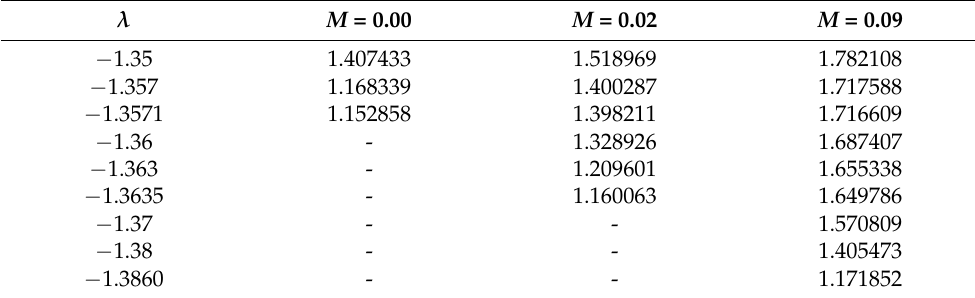
Table 4. Values of f (cid:48)(cid:48) ( 0 ) as φ 1 = φ 2 = 0.01, α = 3.0, β = 0.5, Ec = 0.1, and Pr = 6.2. λ M = 0.00